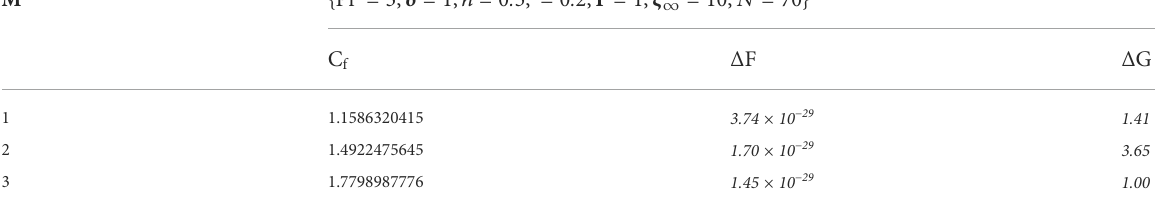
TABLE 4 Numerical estimation of frictional factor C f .